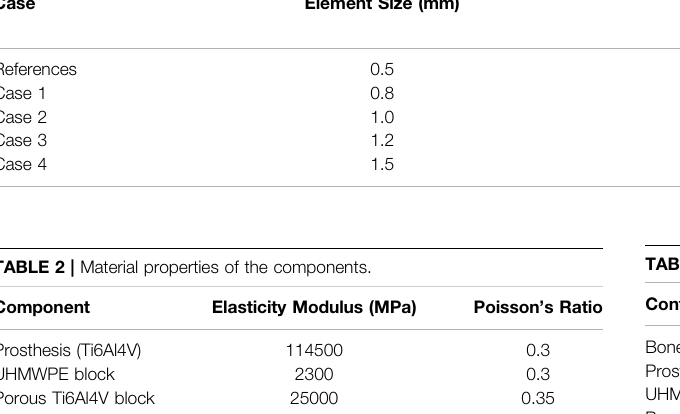
TABLE 1 | Sensitivity analyses on mesh density for bone.